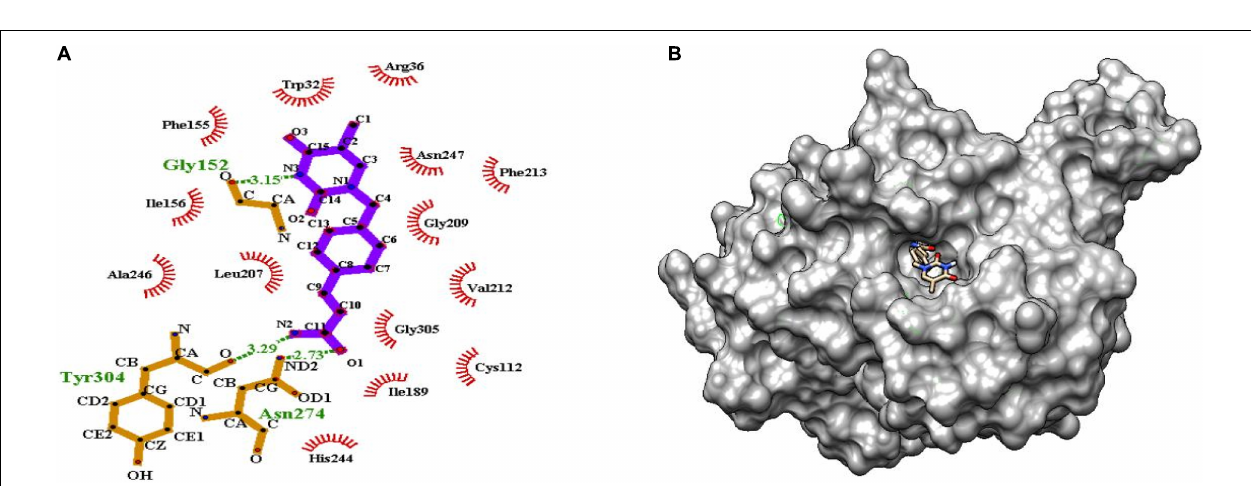
FIGURE 6 | (A) Molecular interaction of lead molecule, ChEMBL414848 (compound C1) at the active site of mtFabH using LigPlot. (B) Surface view of mtFabH-ChEMBL414848 complex.